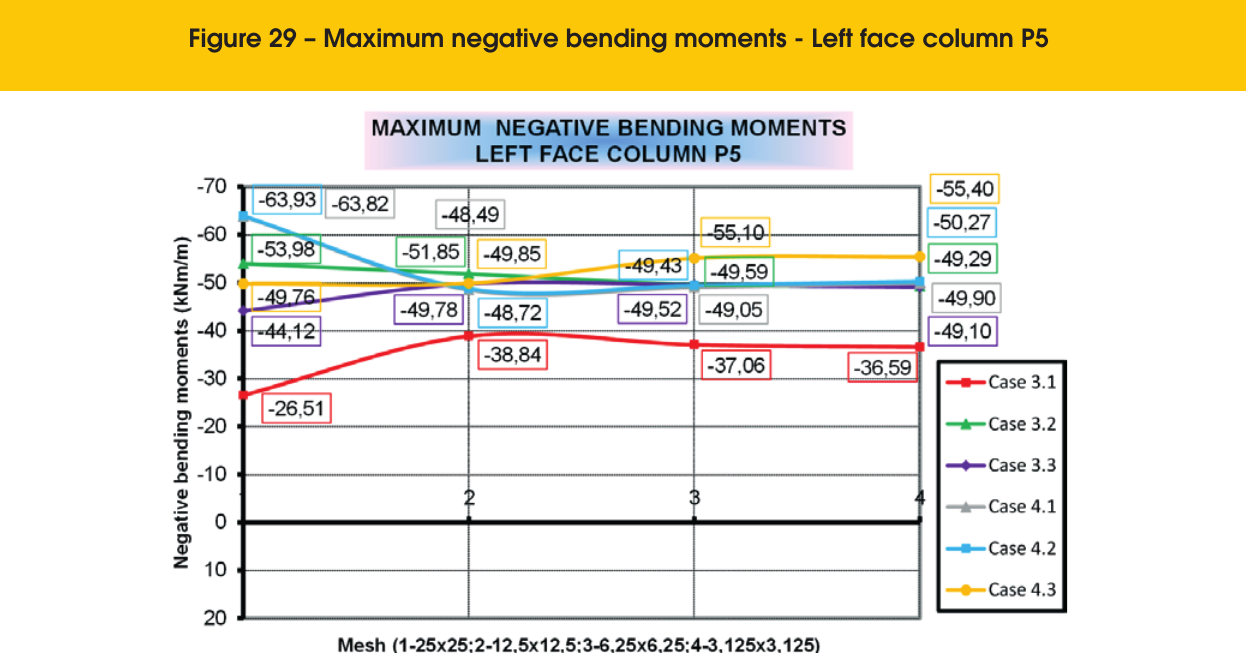
Figure 29 – Maximum negative bending moments - Left face column